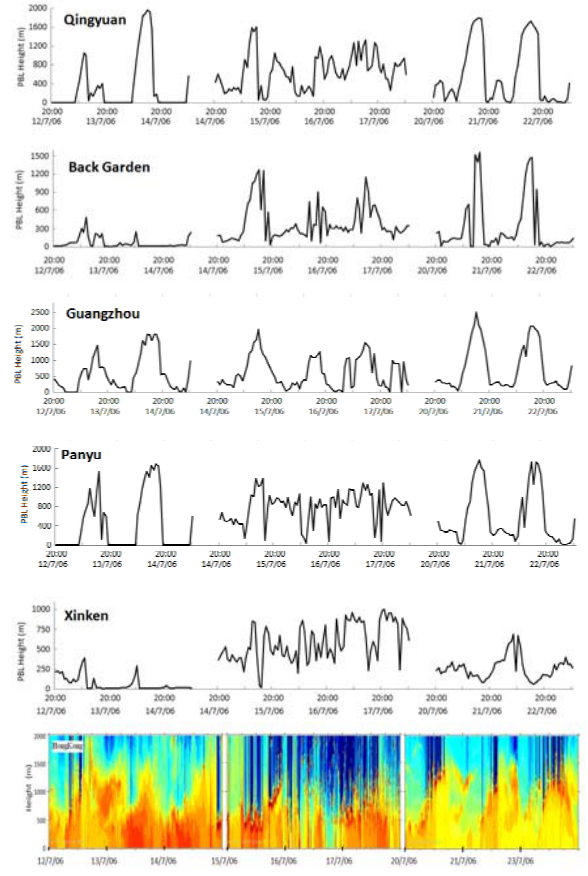
Fig. 6. Variation of the modeled WRF atmospheric boundary layer height (m) at the Qingyuan, Back Garden, Guangzhou, Panyu, and Xinken stations and the LIDAR normalized relative backscattering signal at Yuenlong station in Hong Kong.